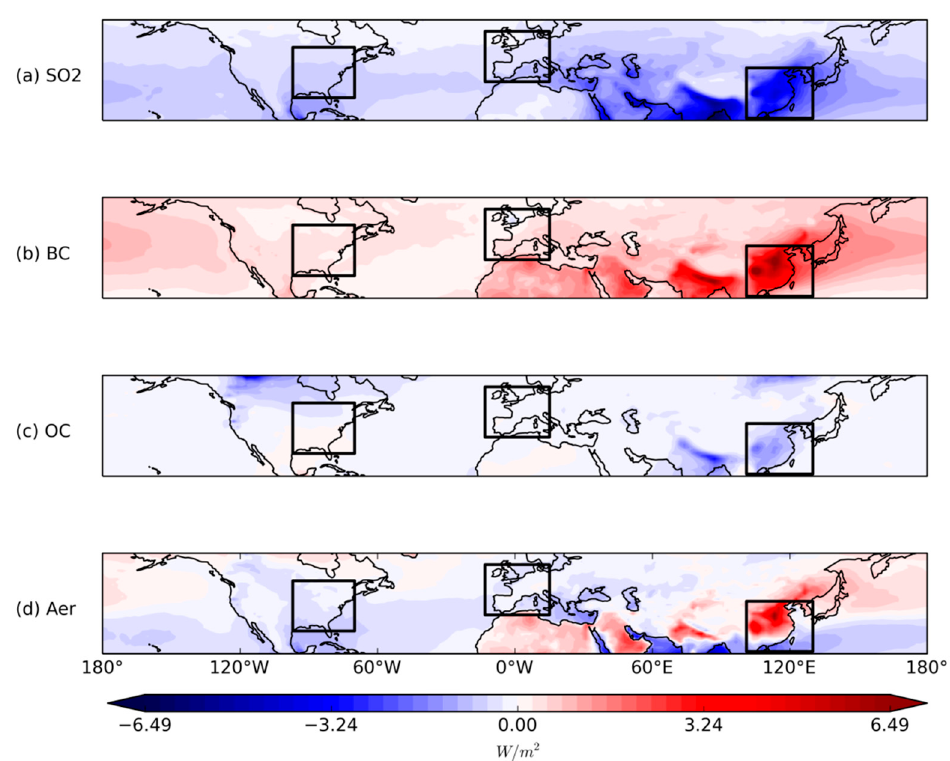
Figure 4. Geographical distribution of the present-day (PD) (2014) instantaneous radiative forcing (IRF) relative to the pre-industrial period (PI) (1850) for ( a ) SO 2 , ( b ) BC, ( c ) OC, and ( d ) all aerosols in W/m 2 .